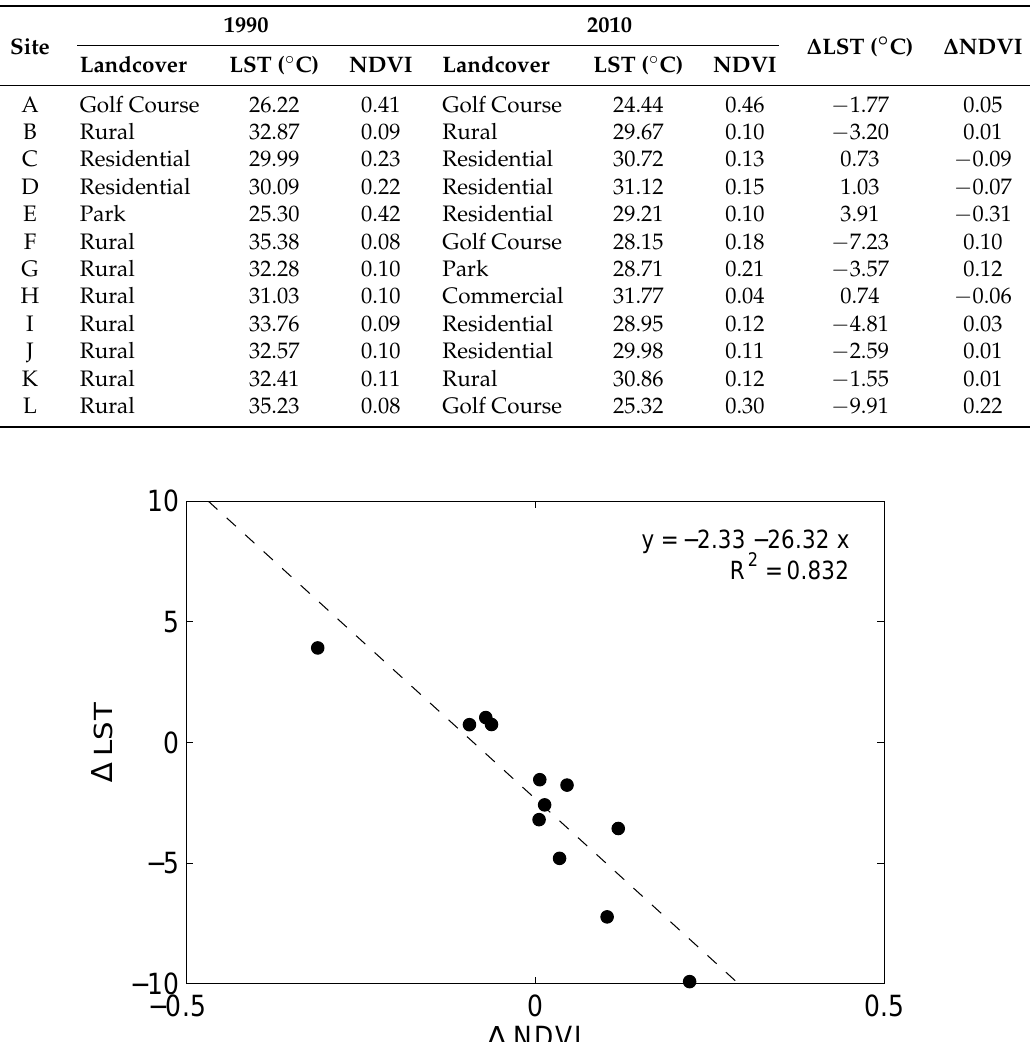
Table 3. List of selected sites showing change in land cover, LST, and NDVI between 1990 and 2010.